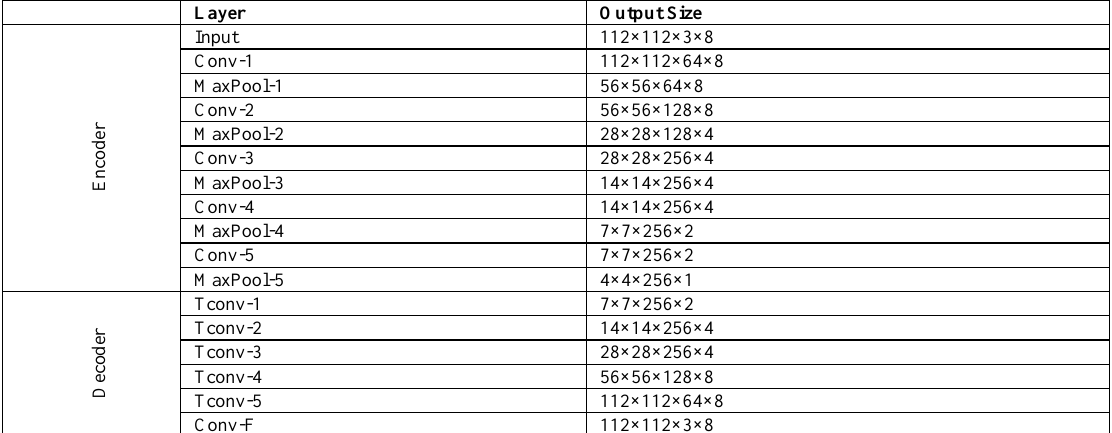
Table 2. 3D-CAE network